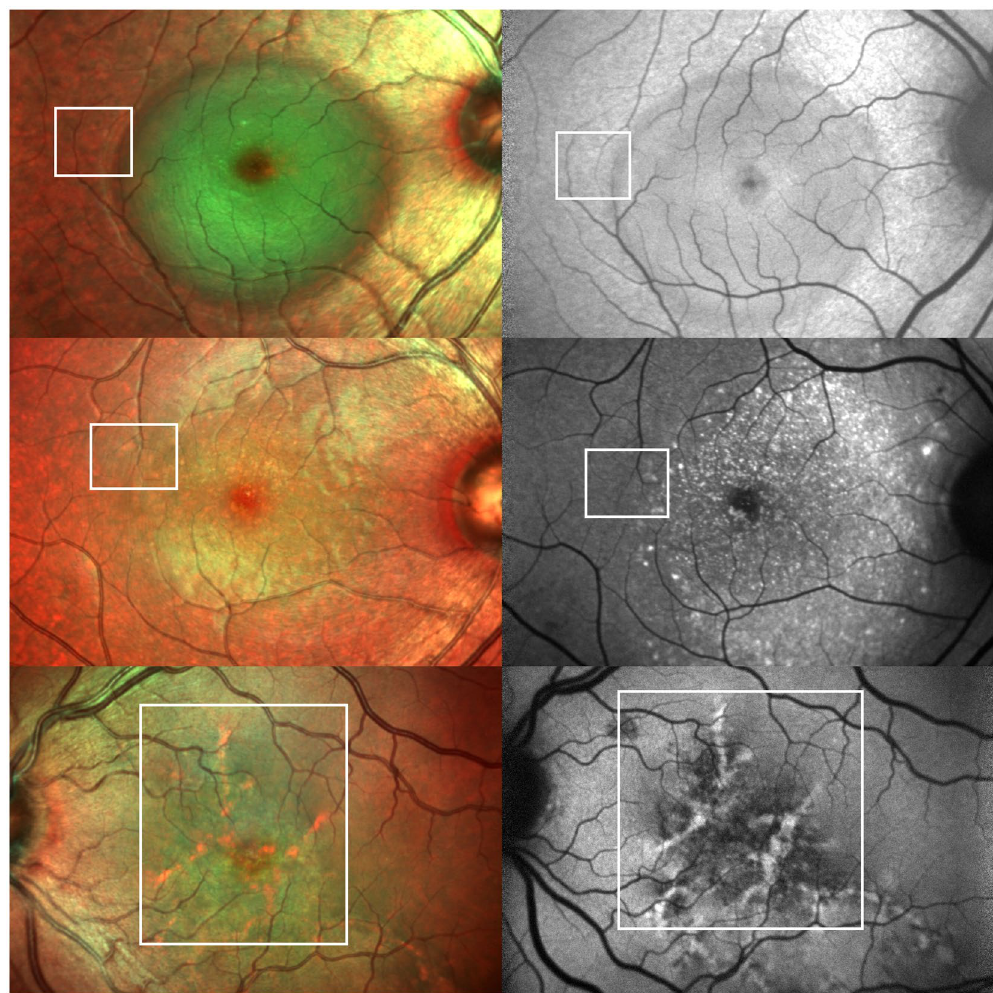
Figure 1. Imaging features of clinical findings in central serous chorioretinopathy (CSCR) on multicolor imaging (MCI) and fundus autofluorescence (FAF) - MCI of various clinical findings are noted on the left while those on the right represent the corresponding FAF images. Top left and right show neurosensory detachment (NSD) with enhanced green reflectance and hypoautofluorescence respectively. Note a few a prominent green subretinal deposits within the NSD in the top left image. Middle left and right demonstrate NSD with subretinal deposits. They appear as discrete green deposits on MCI and as hyperautofluorescent spots on FAF. Bottom left and right depict sequelae of CSCR with a large area of retinal pigment epithelium and inner choroidal atrophy resulting in visualisation of the pachyvessels on both investigations. Note the orange vascular pattern and hyperautofluorescent vessels on MCI and FAF respectively. This is the only eye with clearly visible pachyvessels on FAF. The boxes in all the six images demonstrate colocalisation of pachyvessels on MCI and